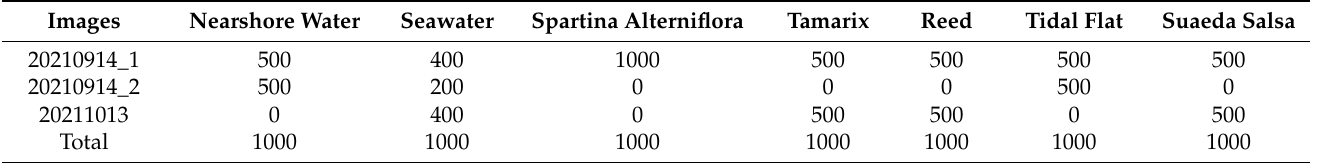
Table 2. Samples distribution.